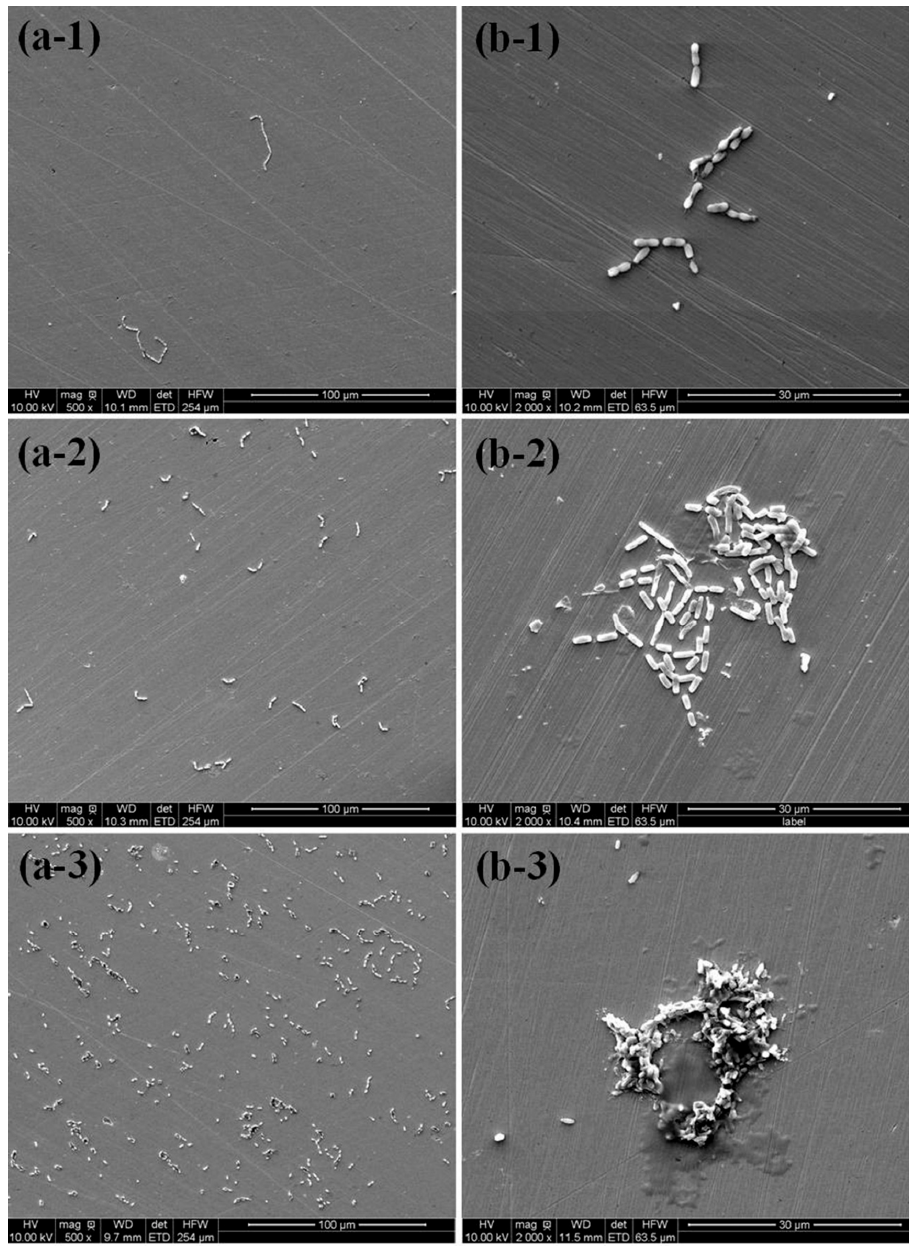
Figure 3. SEM images of the attached Bacillus sp. in different ( a ) pHs and ( b ) at different temperatures